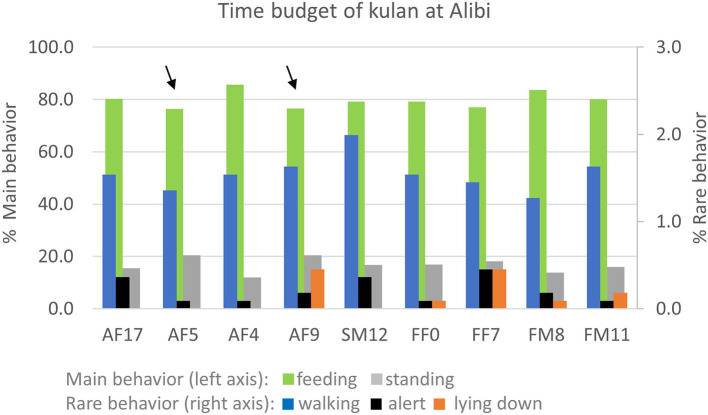
Time budget of nine kulan in the 55 ha acclimatization enclosure at Alibi from 6th Nov 2017 to 26th Mar 2018. Arrows mark the two individuals that had consistently higher egg shedding values.